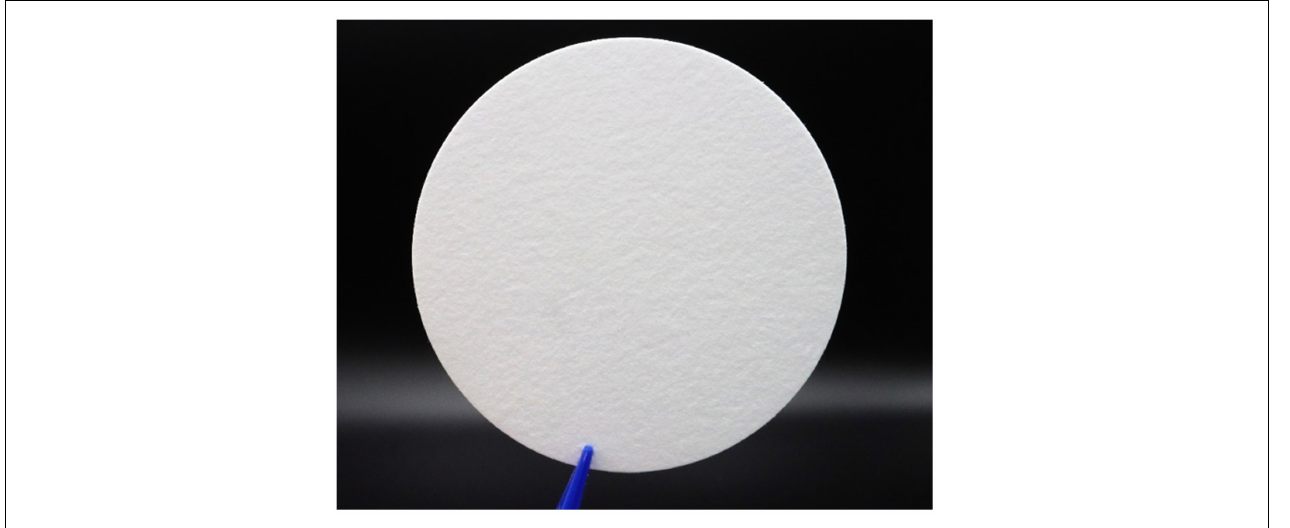
FIGURE 7 | Cellulose microfiber based filter paper for odor soaks.